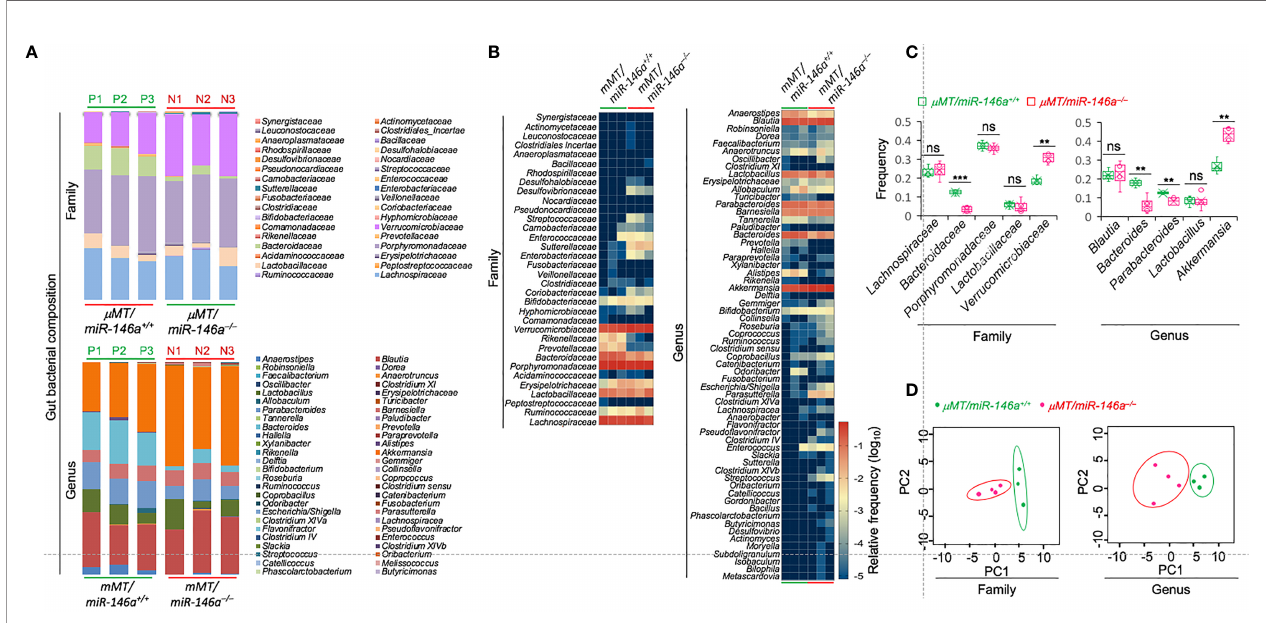
FIGURE 4 | B cell miR-146a de fi ciency alters gut bacterial microbiome in m MT/miR-146a – / – mice. Relative abundance of fecal bacteria families and genera (A, B) in m MT/miR-146a – / – and m MT/miR-146a +/+ chimeric mice ( n =3 per group) as determined by high-throughput 16s rRNA gene miSeq amplicon sequencing. (C) Frequency of fi ve relatively abundant fecal bacteria families and genera in these mice. *** p < 0.001, ** p < 0.01, ns, not signi fi cant, unpaired t -test. (D) Principal component analysis of gut bacterial composition of the fecal bacteria families and genera in m MT/miR-146a – / – and m MT/miR-146a +/+ chimeric mice. Data are from three independent